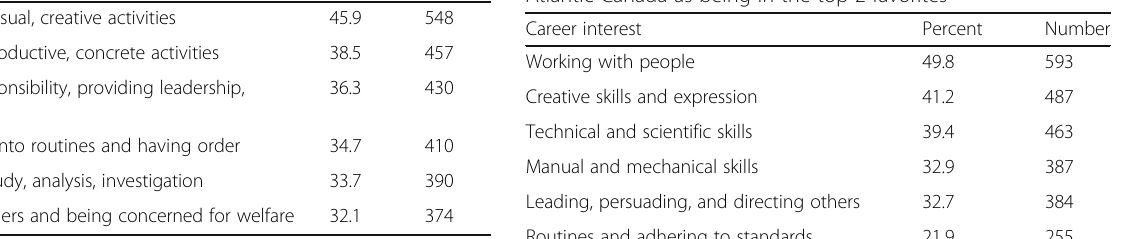
Table 2 Career activities rated by grade 7 and 9 students in Atlantic Canada as being in the top 2 favorites Career activity Percent